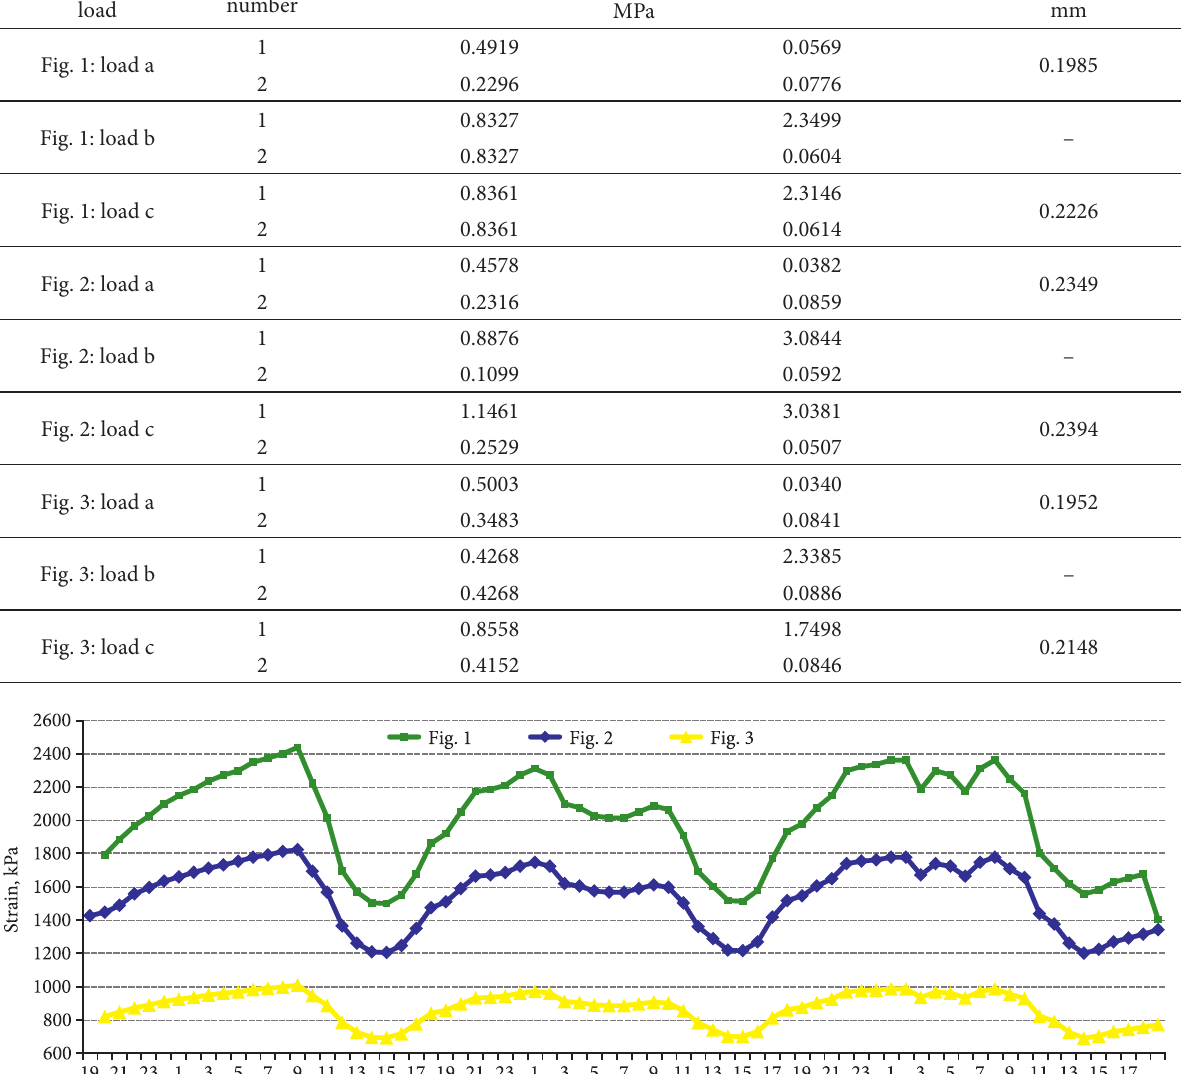
Table 2. Results of the mode of deformation research (Figs 1–3) Model number: